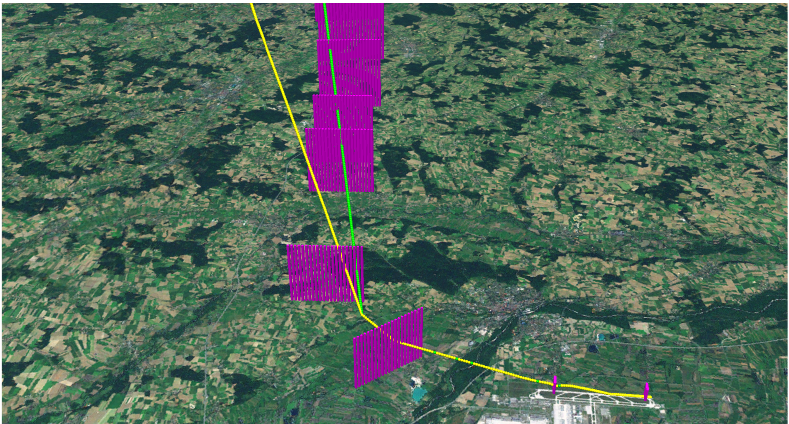
Figure 10. Funnel in the direction of north-west with a free optimized flight profile (yellow) and restricted to the funnel (green).